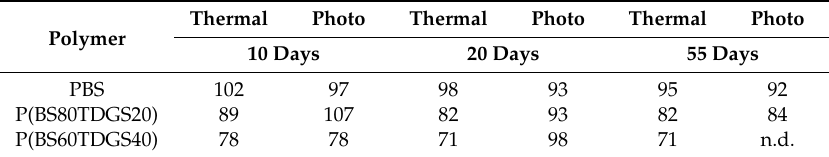
Table 5. Residual ∆ H m (%) after thermal and photoaging in the range 0–55 days.